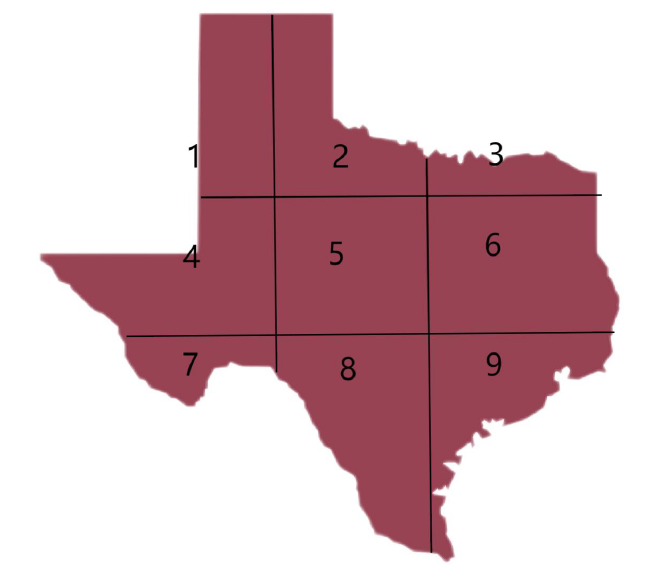
Figure 2. Regional distribution of